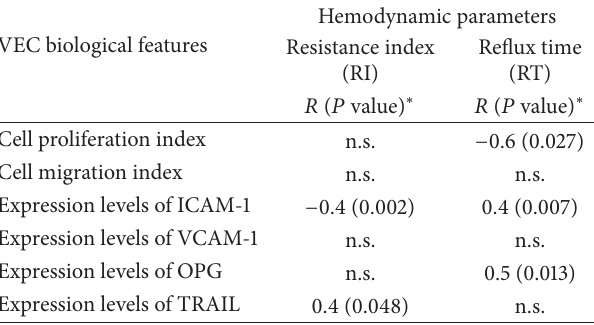
Table 2: In vitro VECbiological features and correlation with in vivo hemodynamic